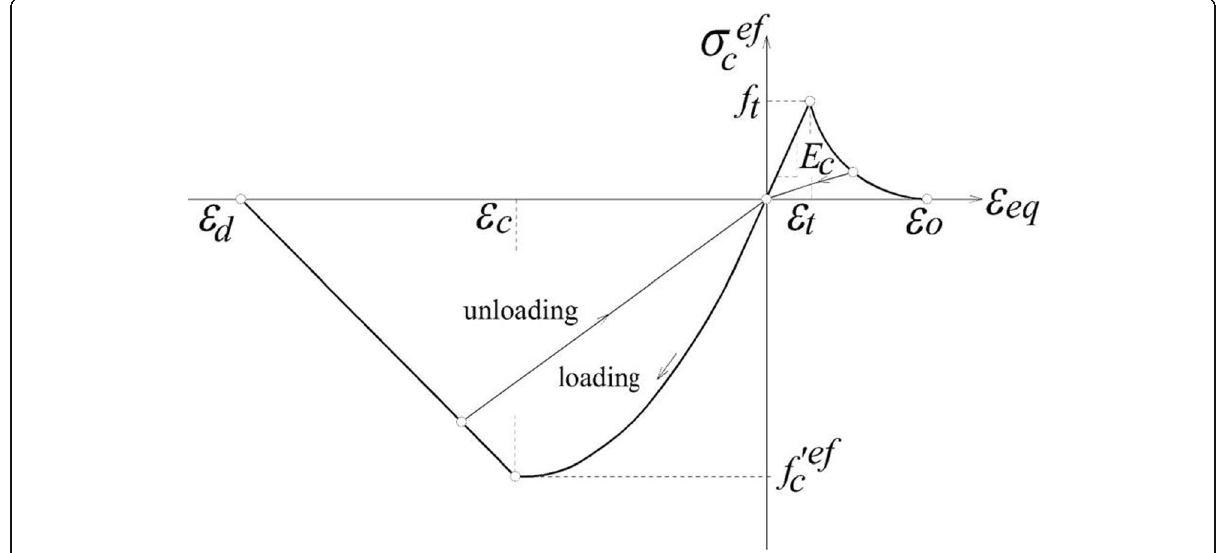
Fig. 6 Stress-strain constitutive relationship in the CC3DNonLinCementitious2 Model of ATENA (reference